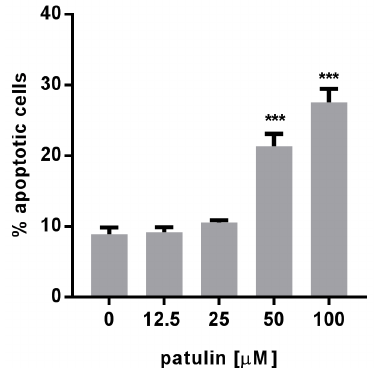
Figure 3 . Dose-dependent increase in percentage of both early and late apoptosis 48 h after patulin treatment, evaluated by the measurement of all annexin V positive cells by flow cytometry ( n = 3). *** p < 0.001.